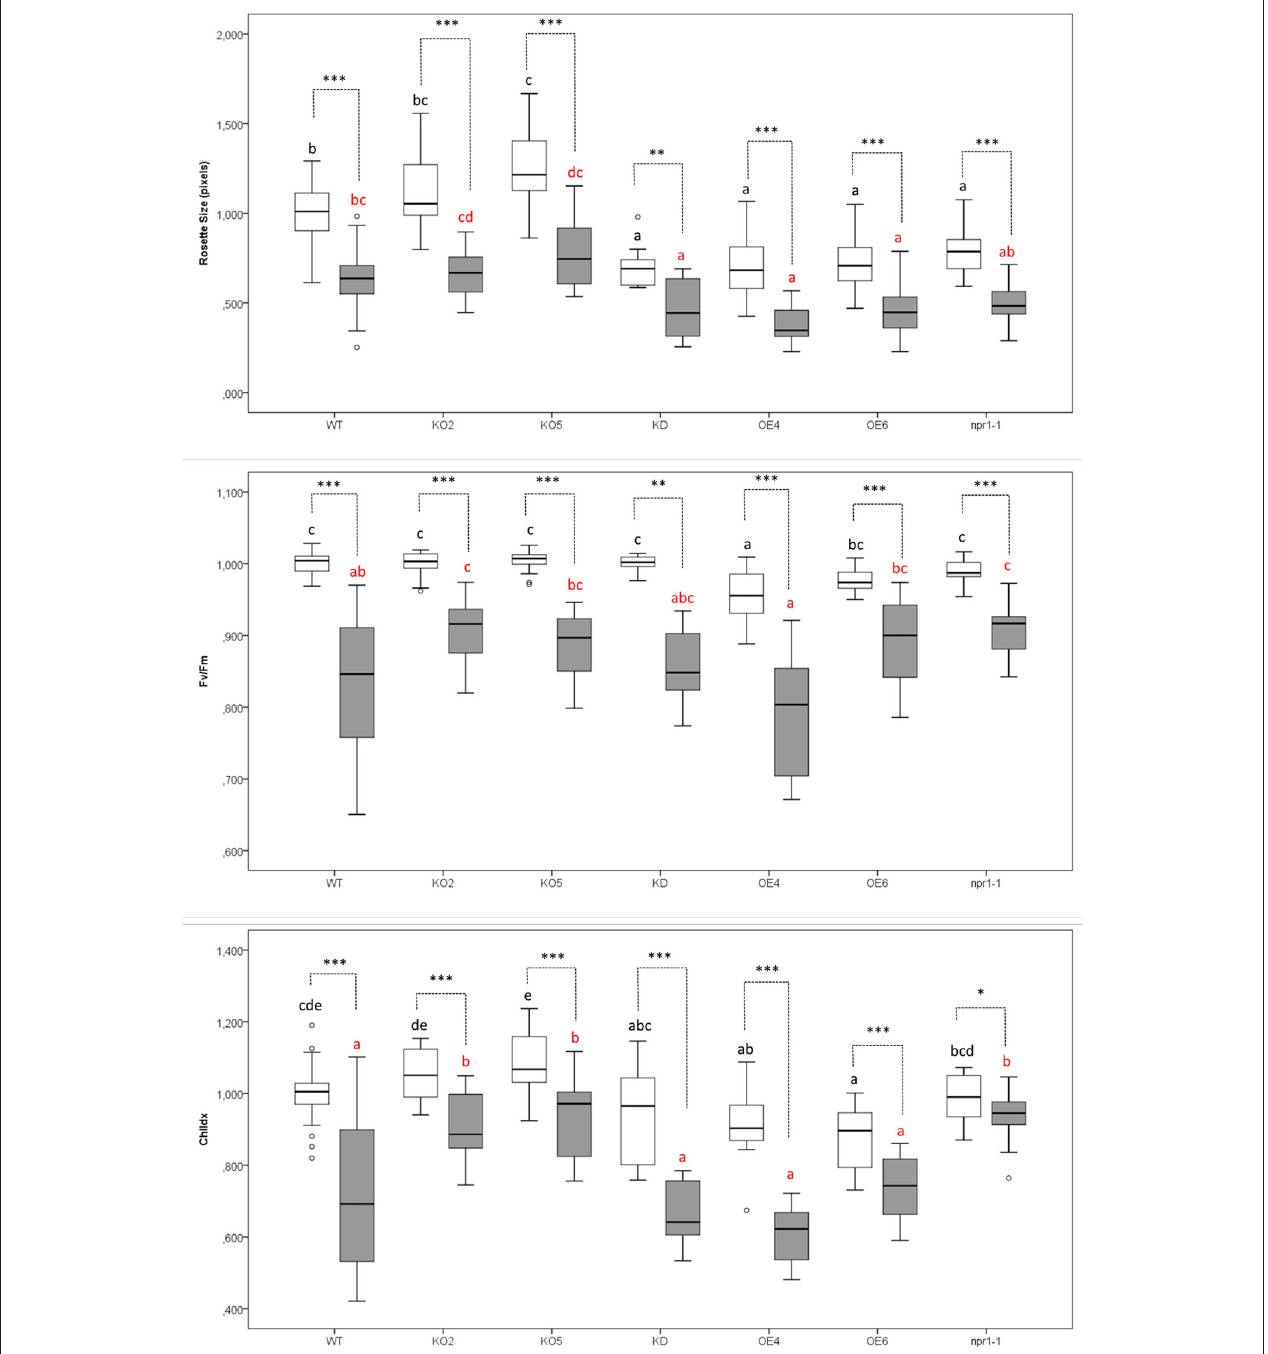
FIGURE 2 | Effect of Pst DC3000 infection on rosette size, the efficiency of photosystem II (Fv/Fm), and chlorophyll content (ChlIdx) in 17-day-old Arabidopsis plants at 3 days after inoculation compared with mock-treated plants. Graphs show mean values with error bars representing standard deviation. For this graph, values of all plant lines and treatments were normalized to the WT mock of each experiment, allowing us to represent two different experiments together in one graph. White boxes represent Mock-treated samples and gray boxes Pst DC3000 infected samples. Comparison of Arabidopsis lines within mock-treated plants (black letters) or Pst DC3000 infected plants (red letters) was done with a one-way ANOVA analysis followed by a post-hoc Tukey test. Significant letters indicate differences at a level of p < 0.05. The comparison between mock and Pst DC3000 treated plants within a plant genotype was done using independent samples T -test for normally distributed data and Mann-Whitney test for non-normally distributed samples. Asterisks indicate statistically significant differences between treatments within the same transgenic line (* p ≤ 0.1; ** p ≤ 0.05; *** p ≤ 0.001). Number of observations (individual rosettes) in mock treatment: WT = 36, KO2 = 18, KO5 = 18, KD = 10 OE4 = 12, OE6 = 18, npr1-1 = 18. Number of observations (individual rosettes) in Pst DC3000 infection treatment: WT = 48, KO2 = 18, KO5 = 18, KD = 10, OE4 = 12, OE6 = 24, npr1-1 = 17.